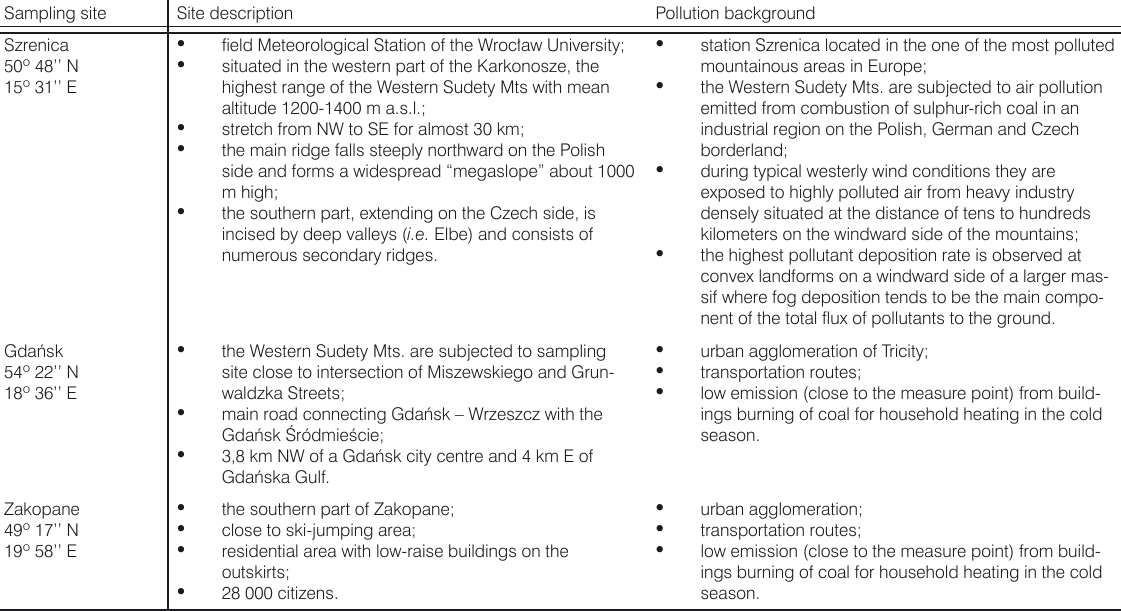
Table 1. Characteristics of the sampling